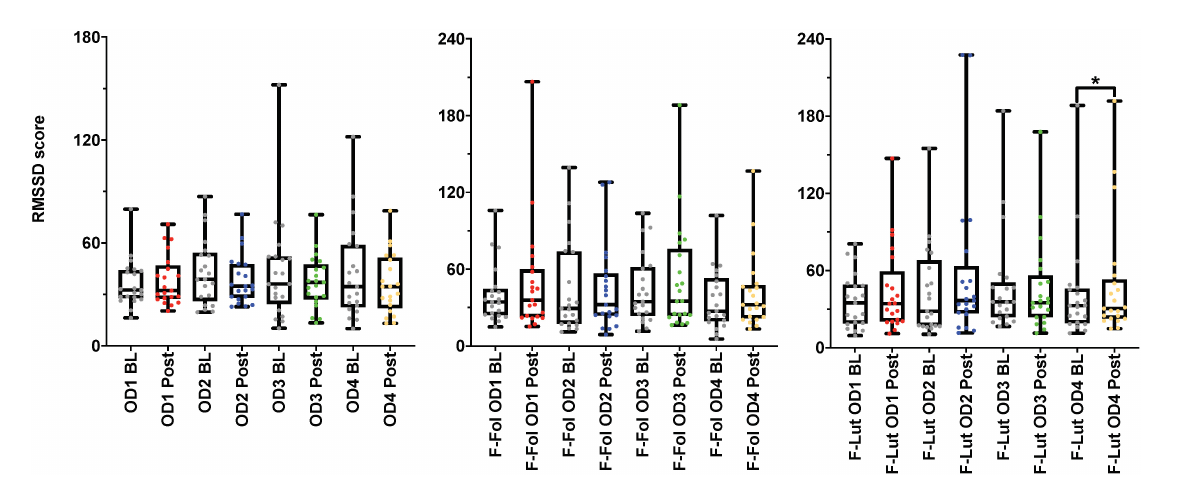
FIGURE3 Results from the baseline (BL) and post-stimulation (Post) periods comparisons, with a focus on root mean square of successive differences between normal heartbeats (RMSSD), the electrocardiogram (ECG) time-domain parameter from both cohorts. The figure on the left represents the RMSSD results from the male cohort, while the ‘F-Fol’ represents the female cohort in the follicular-menstrual stage, while ‘F-Lut’ represents the female cohort in the luteal-menstrual stage. Each graph in the compilation represents each odor (OD1—mushroom, OD2—lavender, OD3—jasmine, OD4—rose). * – p -value < 0.05.